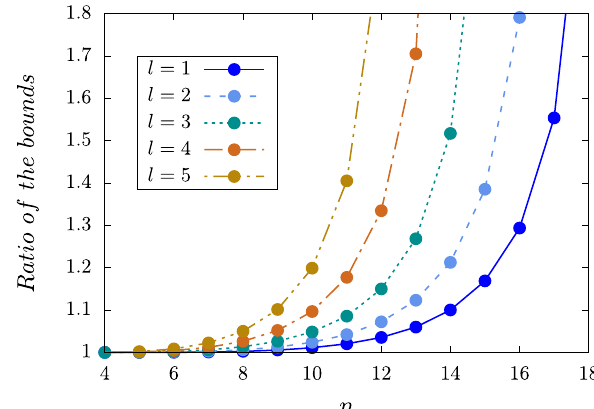
Fig. 7 Here we plot the ratio of the bounds for brane to bulk localized scalar fields with respect to varying spacetime dimensionality n for r H = 1, different values of l and a conveniently chosen frequency ω = 8. This plot corresponds to the second case h =